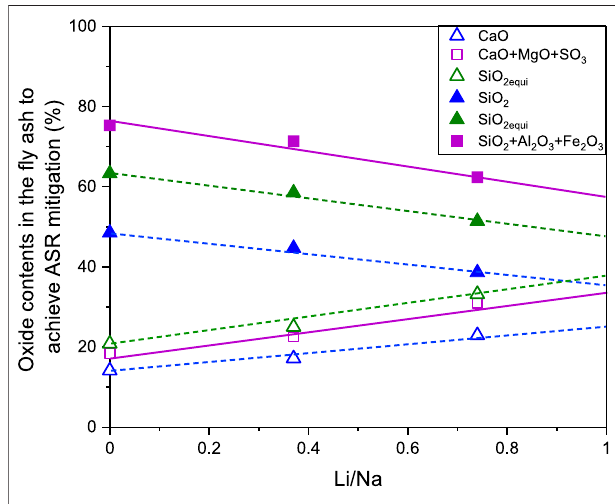
FIGURE 8 | Correlation of chemical contents of fl y ash and lithium dosage required to achieve ASR mitigation at 25% fl y ash replacement level. Data reproduced from (Venkatanarayanan and Rangaraju,